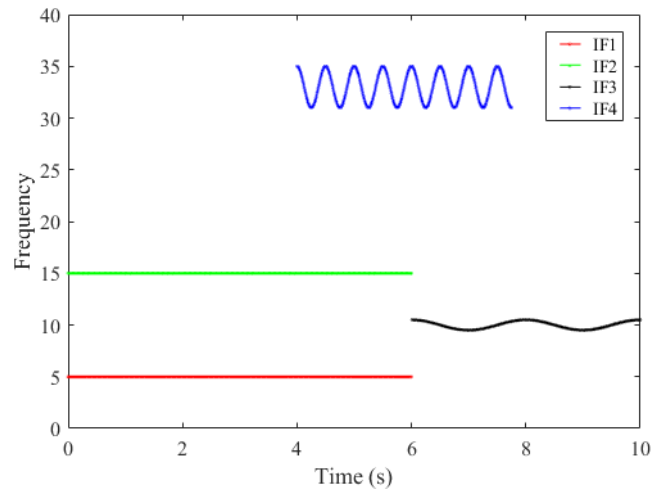
Figure 3. The corresponding instantaneous frequencies of the sub-components in Figure 1.